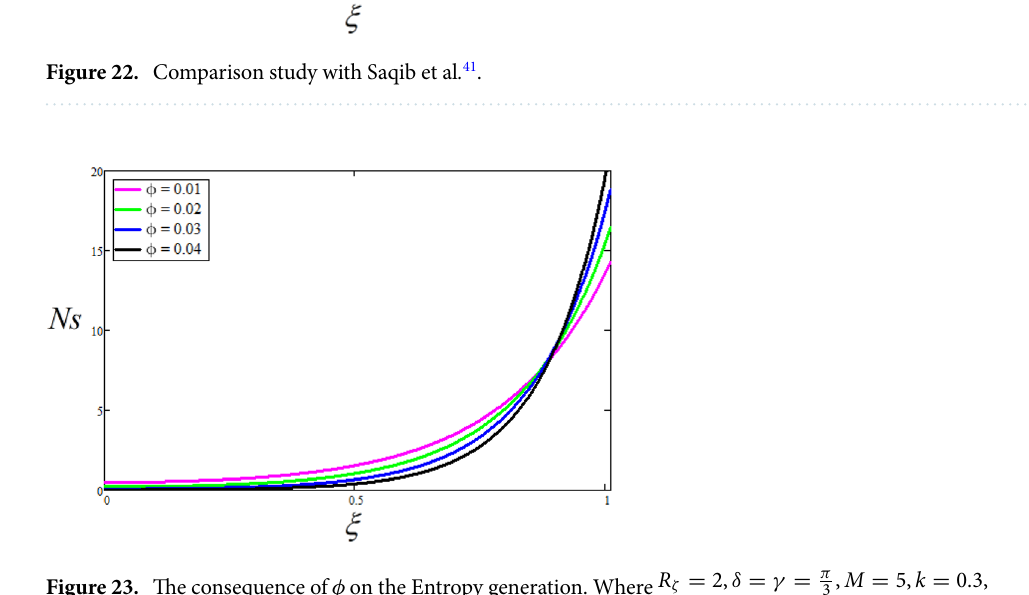
Figure 23. The consequence of φ on the Entropy generation. Where R ζ Gr = 10, Gm = 20, β = 0.2, α = 0.5, t = 1, Sc = 10, B r = 0.5, � =